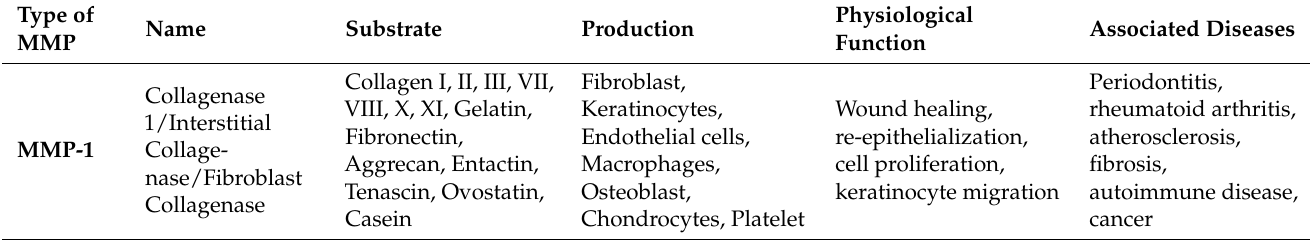
Table 1. MMPS in periodontal lesions modified from the work of Ionut Luchian et al. (Luchian I, Goriuc A, Sandu D, Covasa M. The Role of Matrix Metalloproteinases (MMP-8, MMP-9, MMP-13) in Periodontal and Peri-Implant Pathological Processes. Int J Mol Sci. 2022 , 23 , 1806. https://doi.org/10.3 390/cells9051313. PMID: 35163727; PMCID: PMC8837018. (MDPI open access source)